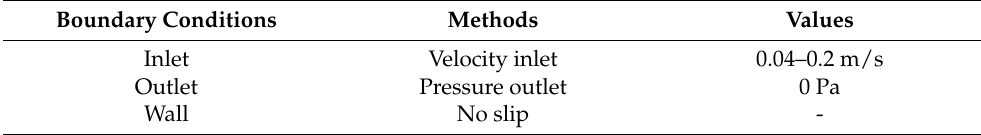
Table 2. Boundary